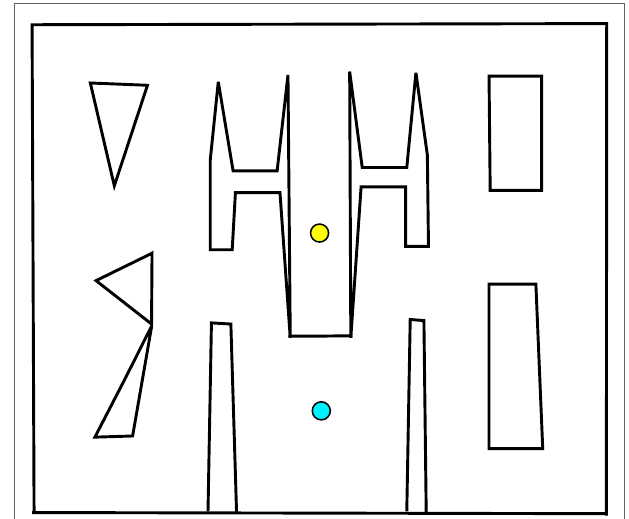
FigUre 1 | small maze . Individuals start at the yellow circle (top) and must navigate to the goal point, marked with a blue circle (bottom). The relative openness and lenient time constraint allow a range of different techniques for reaching the